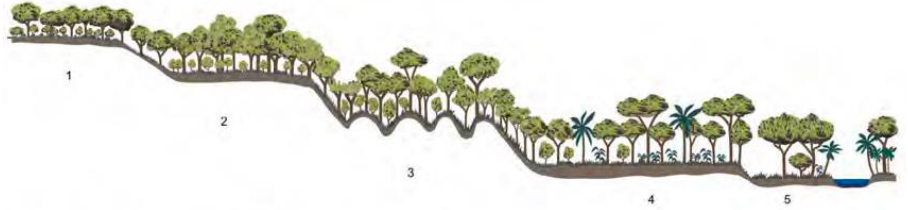
Figure 3. Schematic profile of the Dense Ombrophilous Forest. 1 — Upper-Montane Formation; 2 — Montane Formation; 3 — Submontane Formation; 4 — Lowland Formation; 5 — Alluvial Formation (Modified from [53]).